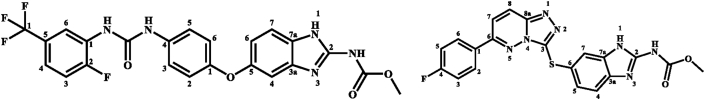
The 2D structure of methyl N-[5-[4-[[2-fluoro-5-(trifluoromethyl)phenyl]carbamoylamino] phenoxy]-1H-benzimidazol-2-yl]carbamate (PDB: GIG) (left panel) and methyl (6-{[6-(4-fluorophenyl)[1,2,4]triazolo [4,3-b]pyridazin-3-yl]sulfanyl}-1H-benzimidazol-2-yl)carbamate (PDB: 63B) (right panel). Atoms number are displayed in consistency with data in Table 3.